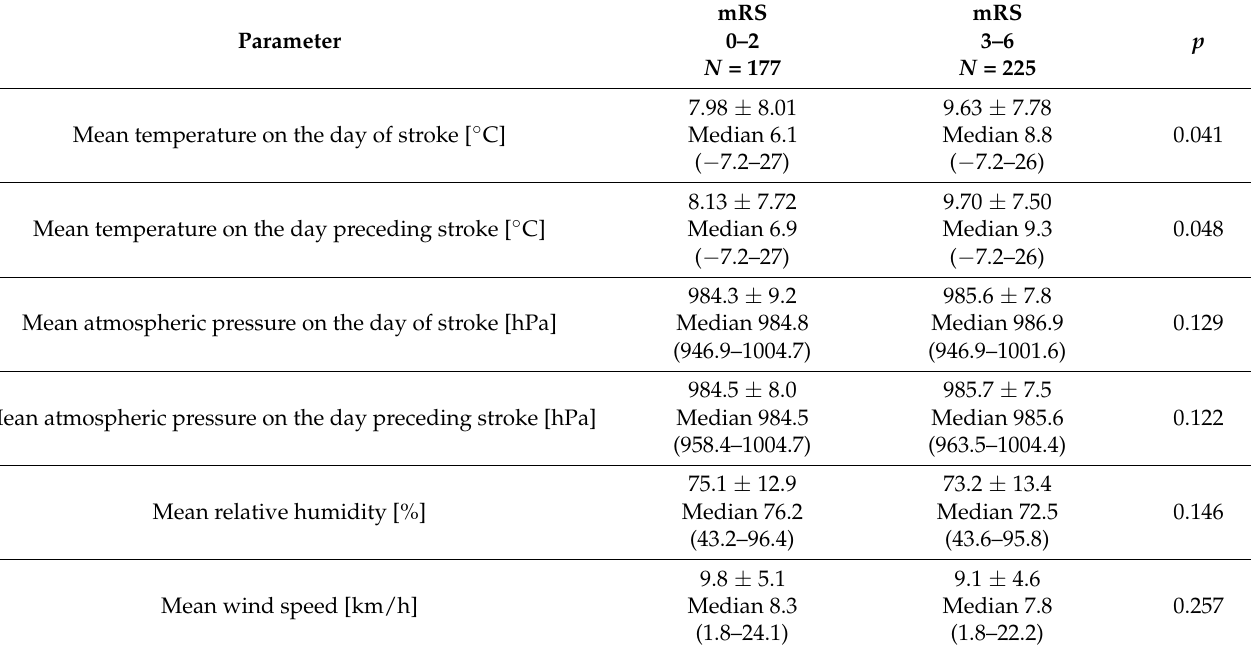
Table 2. Meteorological parameters and functional status of patients as per modified Rankin scale (mRS) on the day of discharge from the Neurology Department.